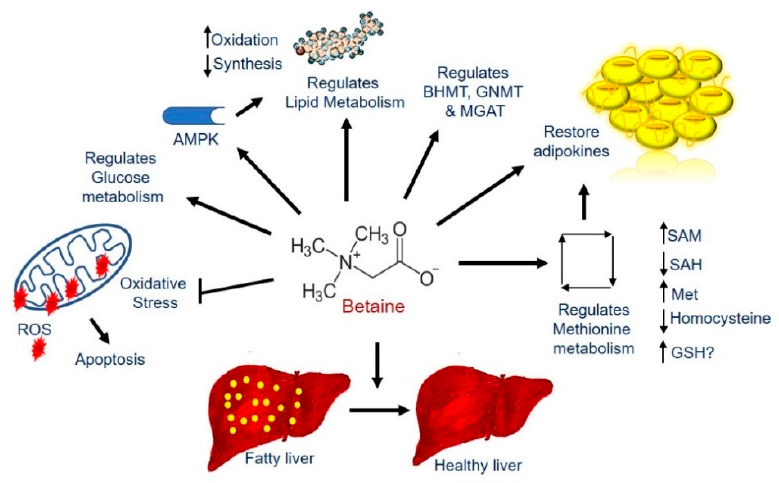
Figure 2. Schematic representation for the functions of betaine in liver.